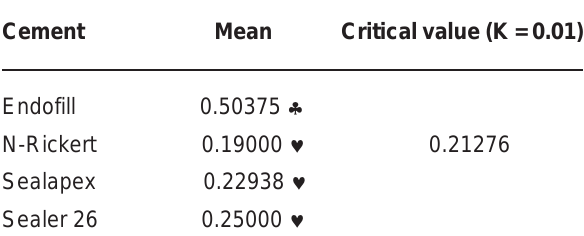
TABLE 2 - Tukey test: between cements TABLE 1- Means (in mm) and standard deviation of the specimens submitted to two different treatments and filled with four types of cements